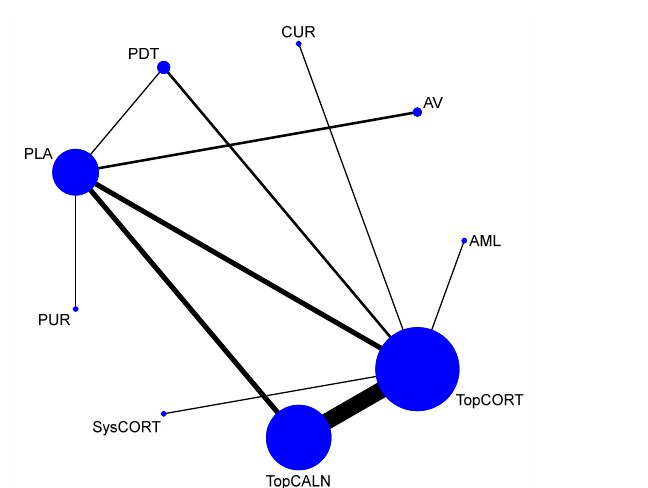
Figure 2. Risk of Bias [1,11,25–57].